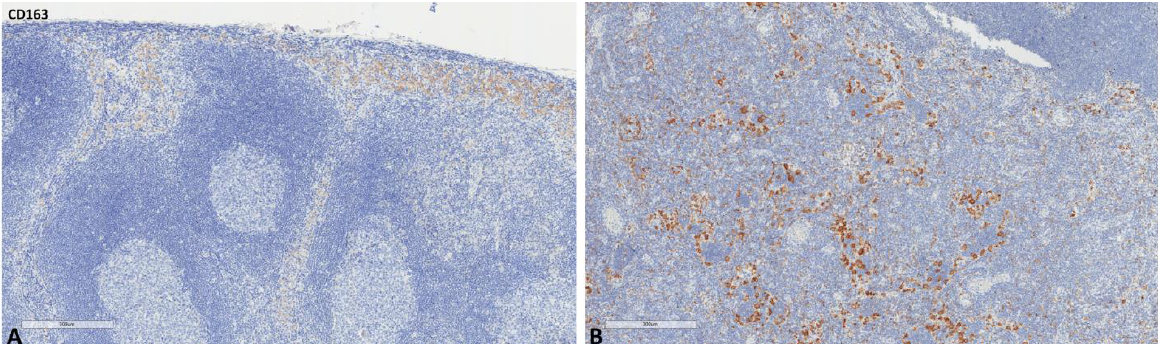
Figure 2. Representative microscopic images of CD8 expression in a normal cancer-draining lymph node ( A ) and a normal non-cancer-draining lymph node ( B ).